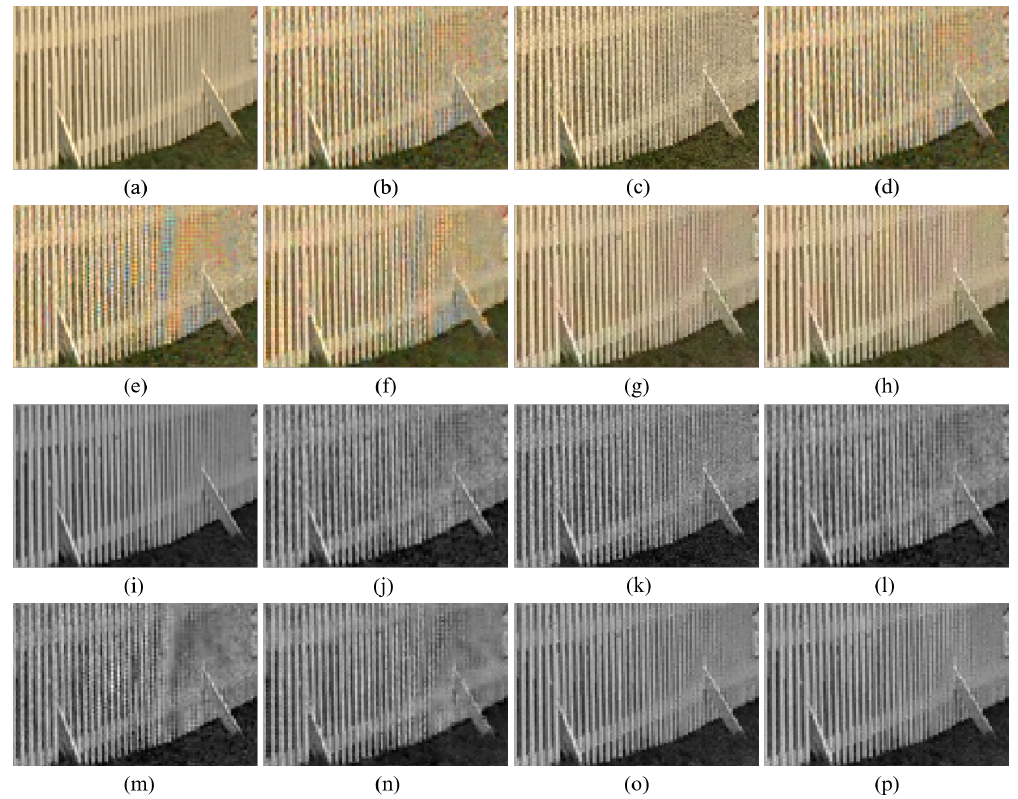
Figure 11. Demosaicing results when none of the channels has low intensity values. The first and the second rows show the reconstructed color images, while the third and the fourth rows show the Blue channels. ( a ) Original ( b ) ICC [12], ( c ) DNet [13] ( d ) RI [14] ( e ) ARI [15] ( f ) Sony [27] ( g ) Paul’s [36] ( h ) Proposed ( i ) Original ( j ) ICC [12] ( k ) DNet [13] ( l ) RI [14] ( m ) ARI [15] ( n ) Sony [27] ( o ) Paul’s [36] ( p ) Proposed.